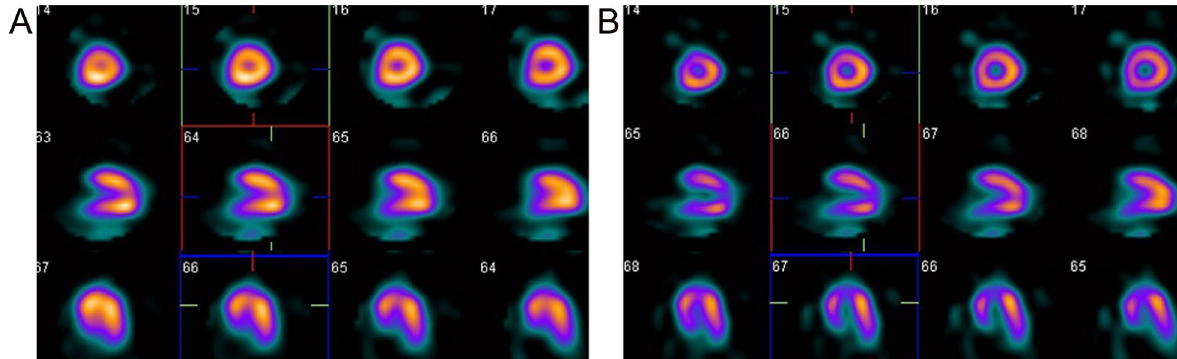
Fig. 3 Comparison of image quality in patients with small heart size. A Representative tomography image of a 59-year-old female with a small heart. The number of iterations was 10, and the number of subsets was 3. B Representative tomography image for which the number of iterations was 18 and the number of subsets was 8. Image A is smoother than image B. The left ventricle is smaller in image A than in image B